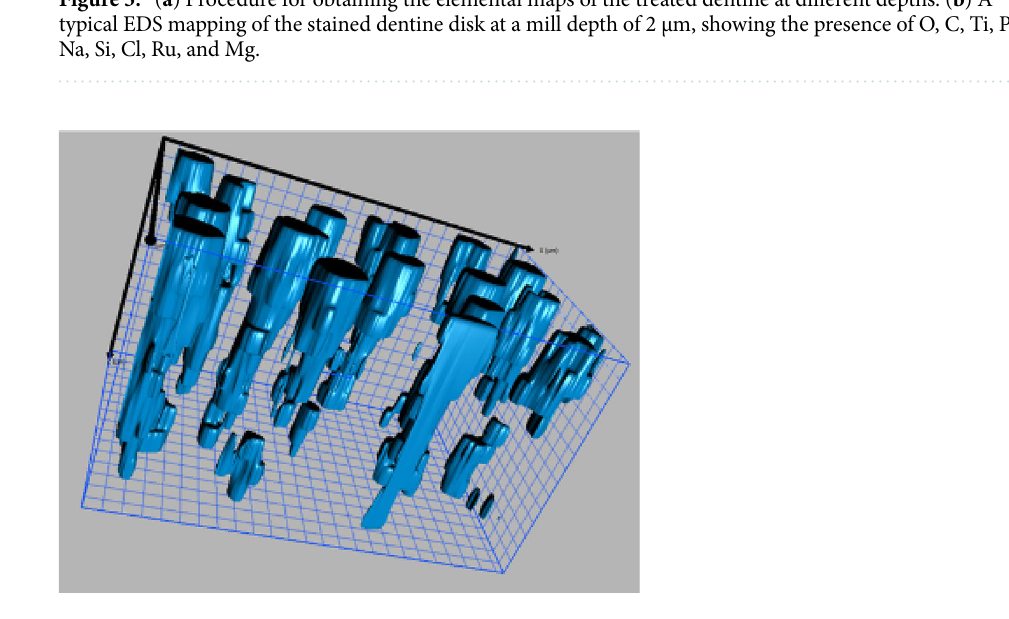
Figure 6. 3-D EDS image of the silica occluded in the dentine tubules, grid size: 1